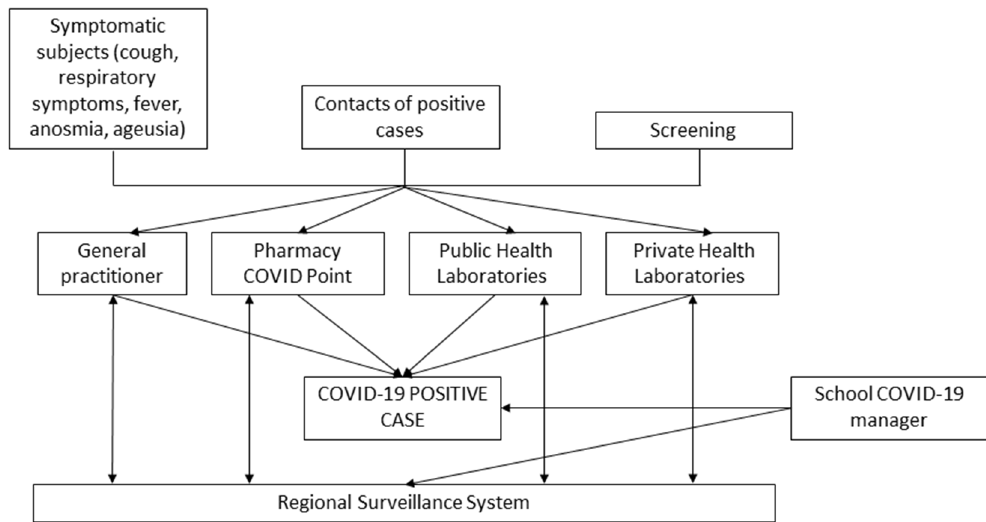
Figure 2. Summary of the school surveillance system.